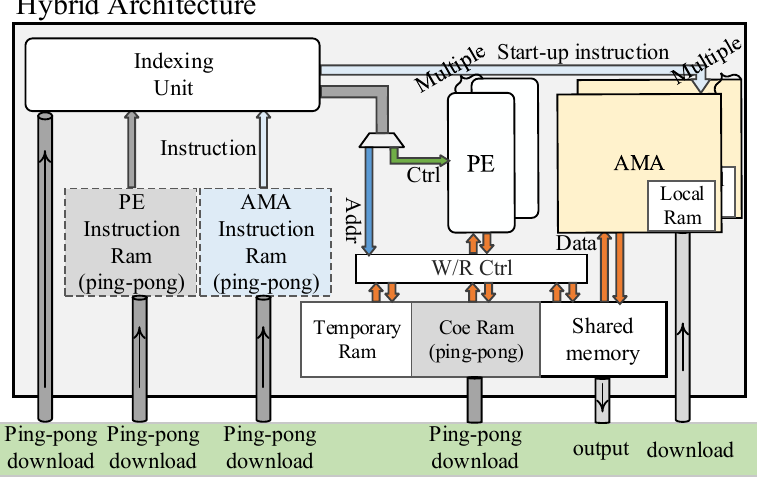
Figure 8. Hybrid architecture based on FPGA.